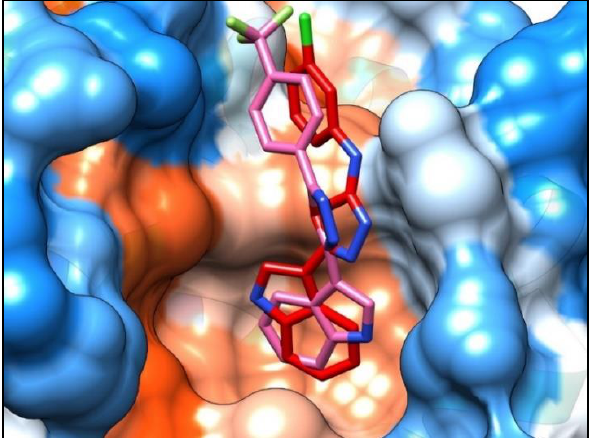
Figure 2. Compound 4j (pink stick) showed a similar binding mode to our previous lead compound 5-(1 H -indol-3-yl)-N-(3-chlorophenyl)-1,3,4-oxadiazol-2-amine [5] (red stick). Both compounds showed a good fit within the hydrophobic pocket of the Bcl-2 protein.